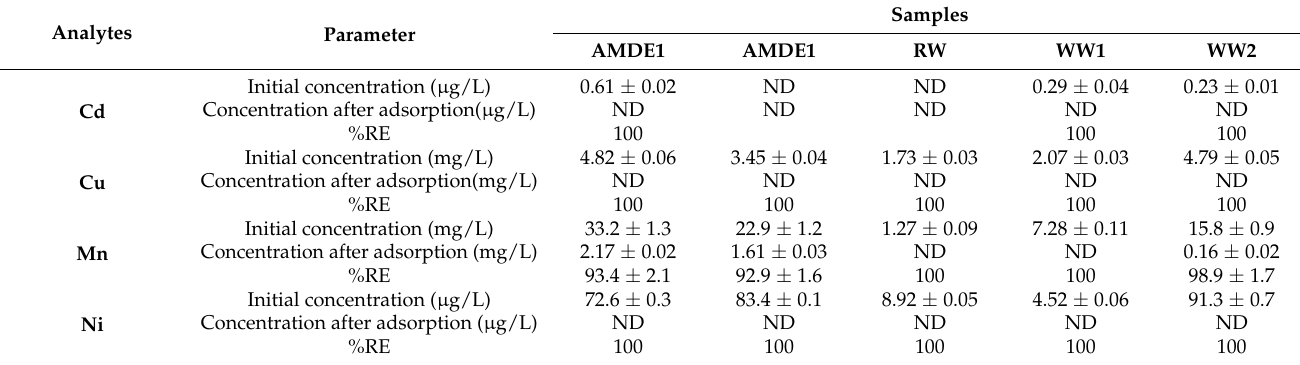
Table 5. The analysis of real water